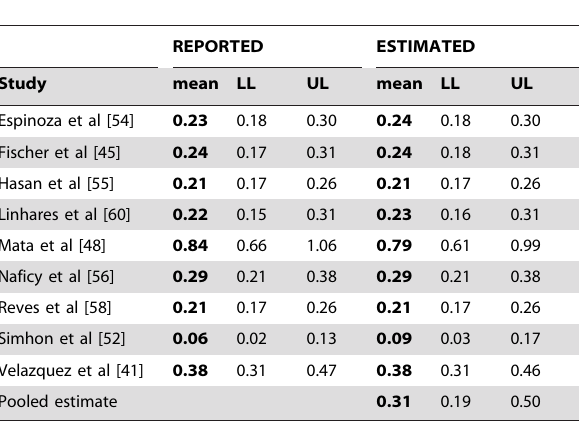
Table 2. Reported and estimated (study-heterogeneous meta-analysis model) incidence values of symptomatic RV infections in children , 2 years.